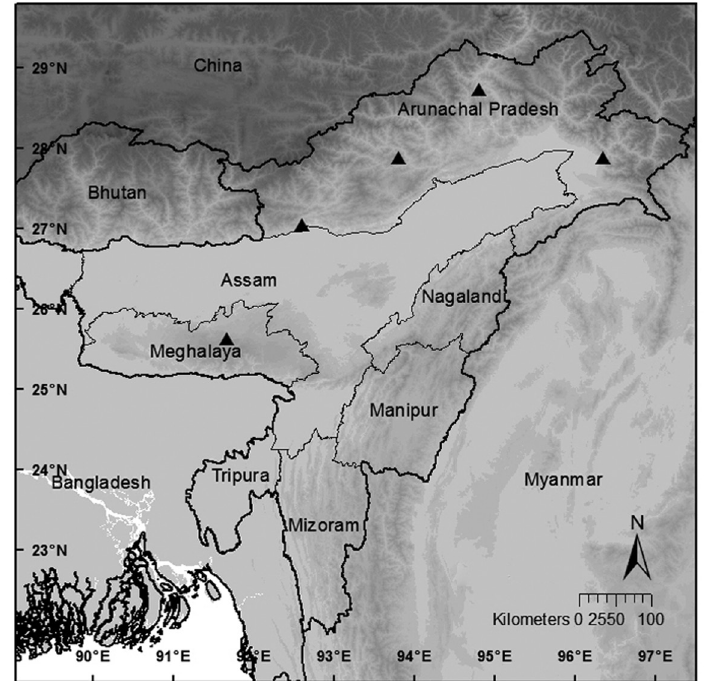
Fig. 65. Map showing the location of B. xanthina Hook.